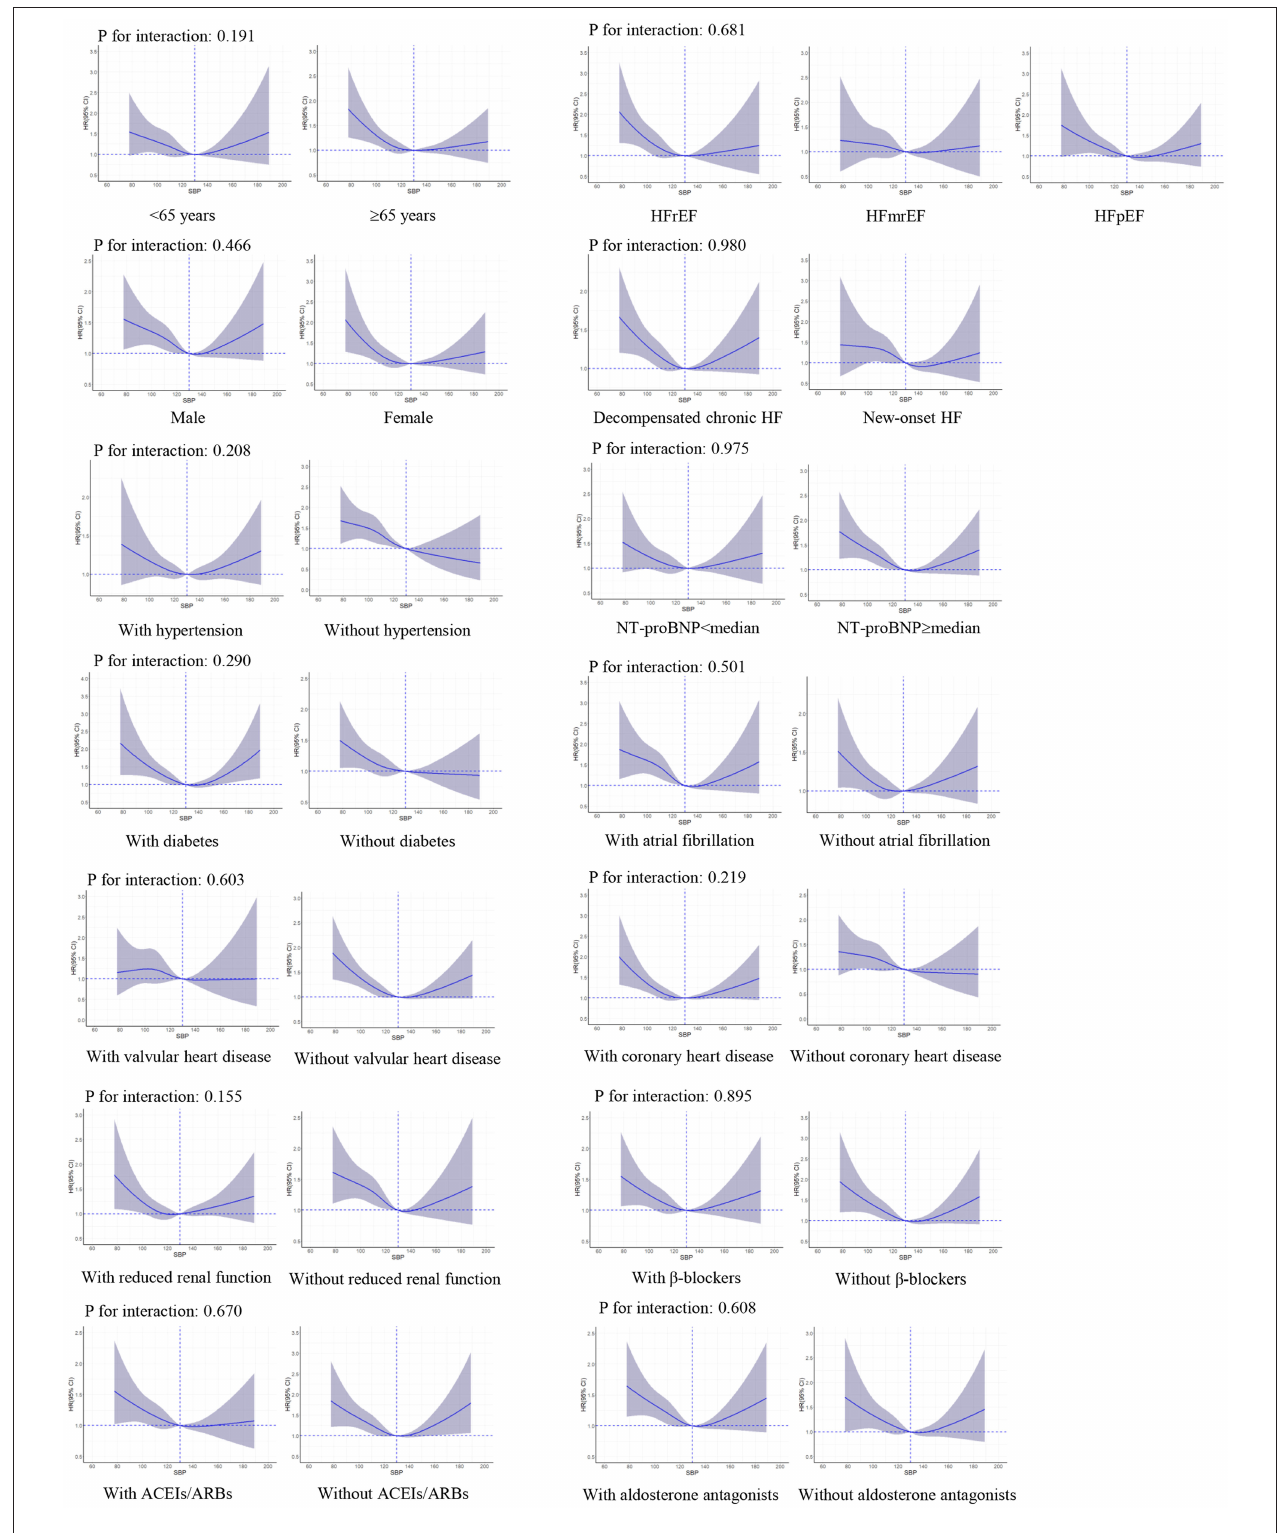
FIGURE 4 | Restricted cubic spline curves for an association between systolic blood pressure and HF readmission in subgroups. SBP of 130 mmHg was applied as the reference. ACEIs, angiotensin-converting enzyme inhibitors; ARBs, angiotensin II receptor blockers; CI, confidence interval; HR, hazard ratio; HF, heart failure; HFrEF, heart failure with reduced ejection fraction; HFmrEF, heart failure with mid-range ejection fraction; HFpEF, heart failure with preserved ejection fraction; NT-proBNP, N-terminal pro-brain natriuretic peptide; SBP, systolic blood pressure.